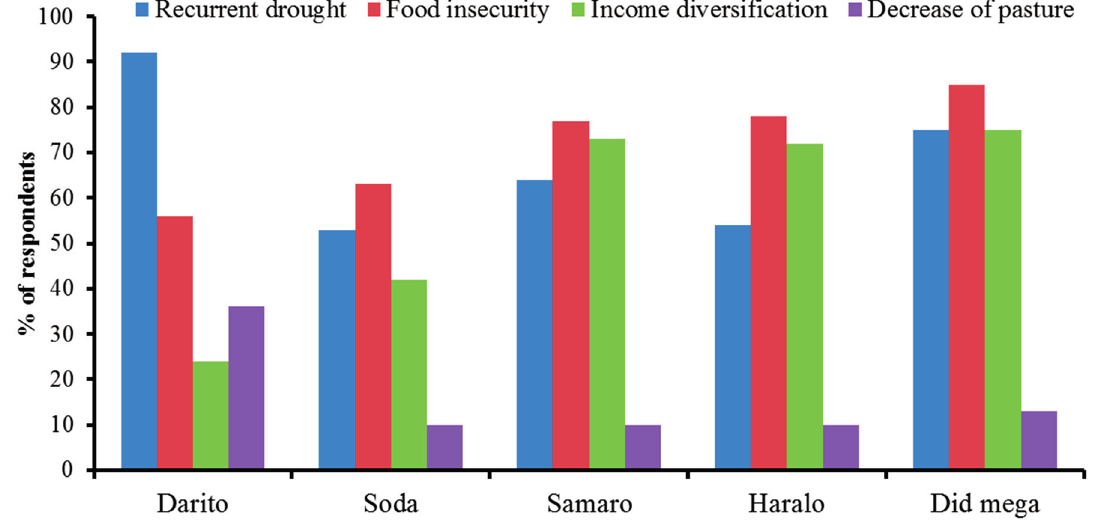
Figure 6. Drivers behind the expansion of cultivation in the study